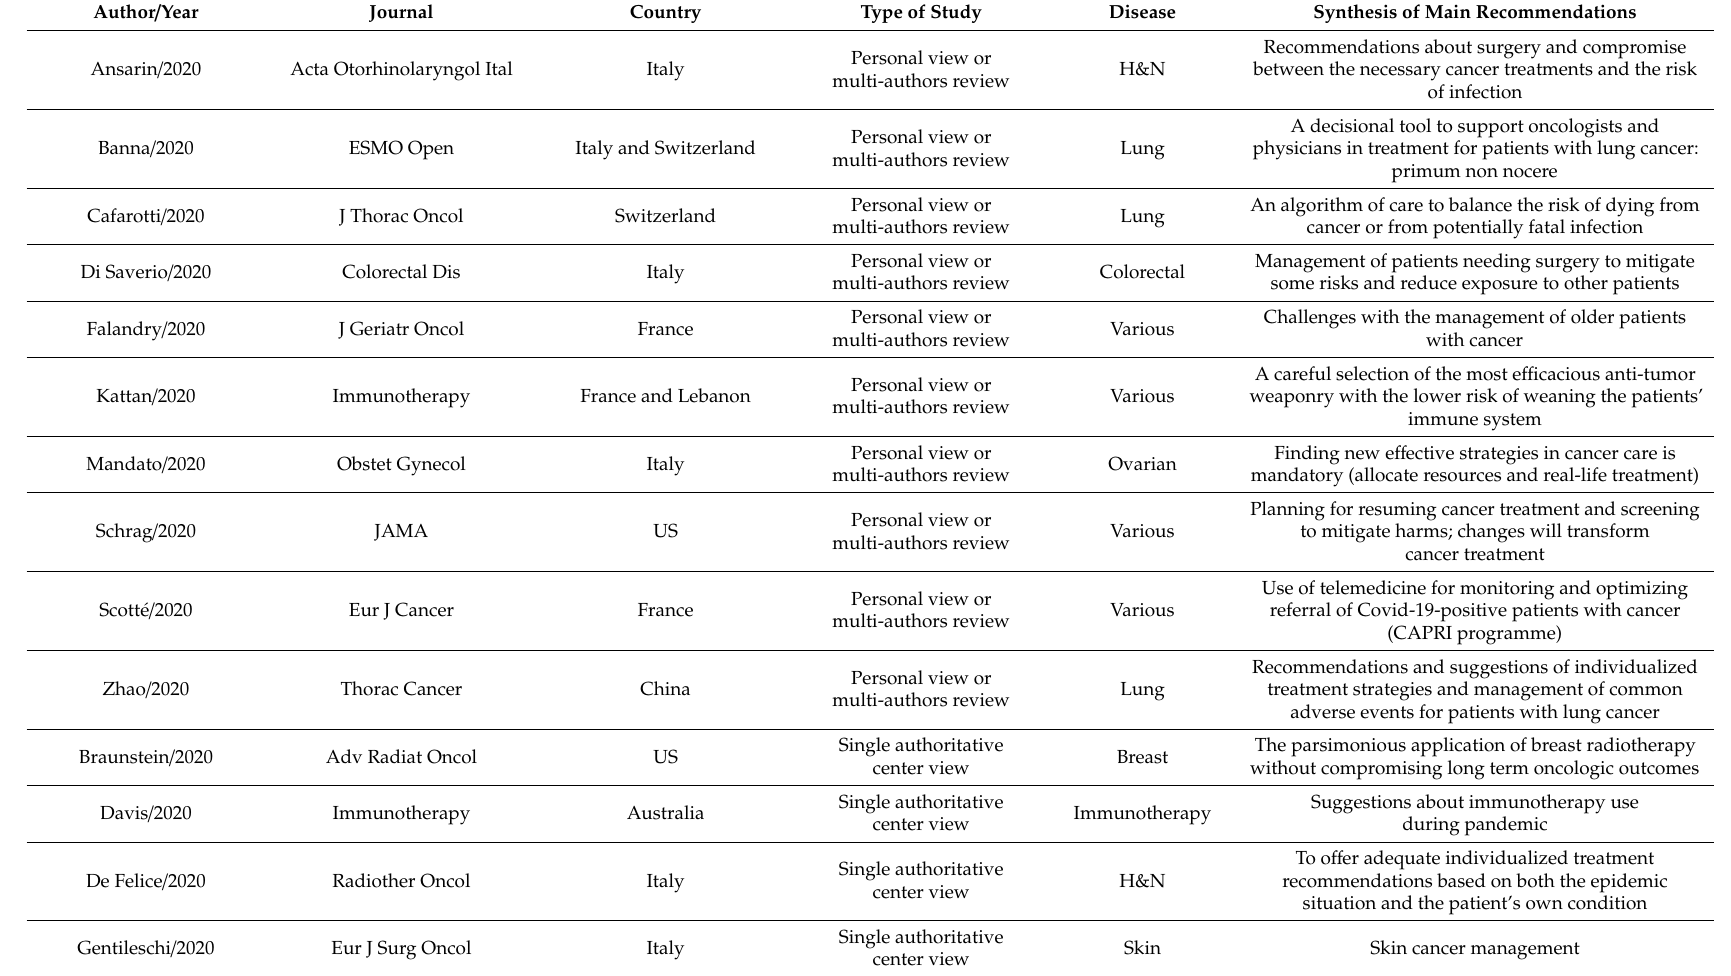
Table 1. Characteristics of included